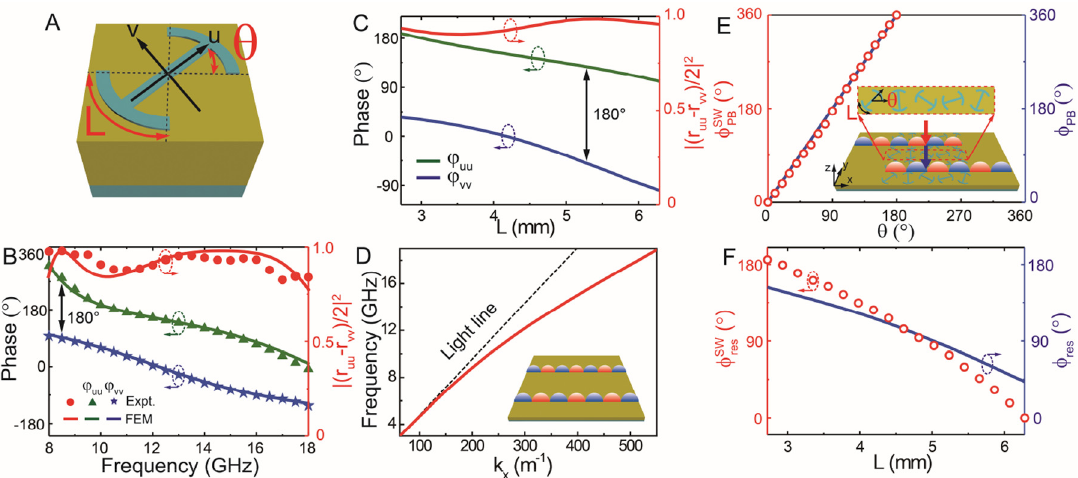
Figure 2: Characterizations on the designed meta-atoms and plasmonic metal. (A) Geometryof the designedmeta-atom(sized6 × 6mm 2 ) consistingof ametallicconnected-double-ringanda fl at metallicmirrorseparated by a 3 mm thick dielectric spacer. The radius and width of the double-ring are 2.5 and 0.2 mm, respectively. (B) Measured and simulated spectra of re fl ection-phase ( φ and φ ) and working ef fi ciency R a of the meta-atoms. (C) Re fl ection phases ( φ uu vv ef fi ciency R a for a series of meta-atoms with different L , obtained by numerical simulations at 12 GHz. (D) Finite-element-method (FEM)- simulated dispersion relation (red line) of the eigen SWs supported by the plasmonic metal as depicted in the inset. (E) Pancharatnam-Berry (PB) phases of meta-atoms with different θ with L fi xed at 3.98 mm, obtained by both near- fi eld calculations (see inset) and far- fi eld calculationsat12GHz.(F)Resonantphasesofmeta-atomswithdifferent L with θ fi xedat0 ∘ ,obtainedbybothnear- fi eldcalculations(seeinset to Figure 2E) and far- fi eld calculations at 12